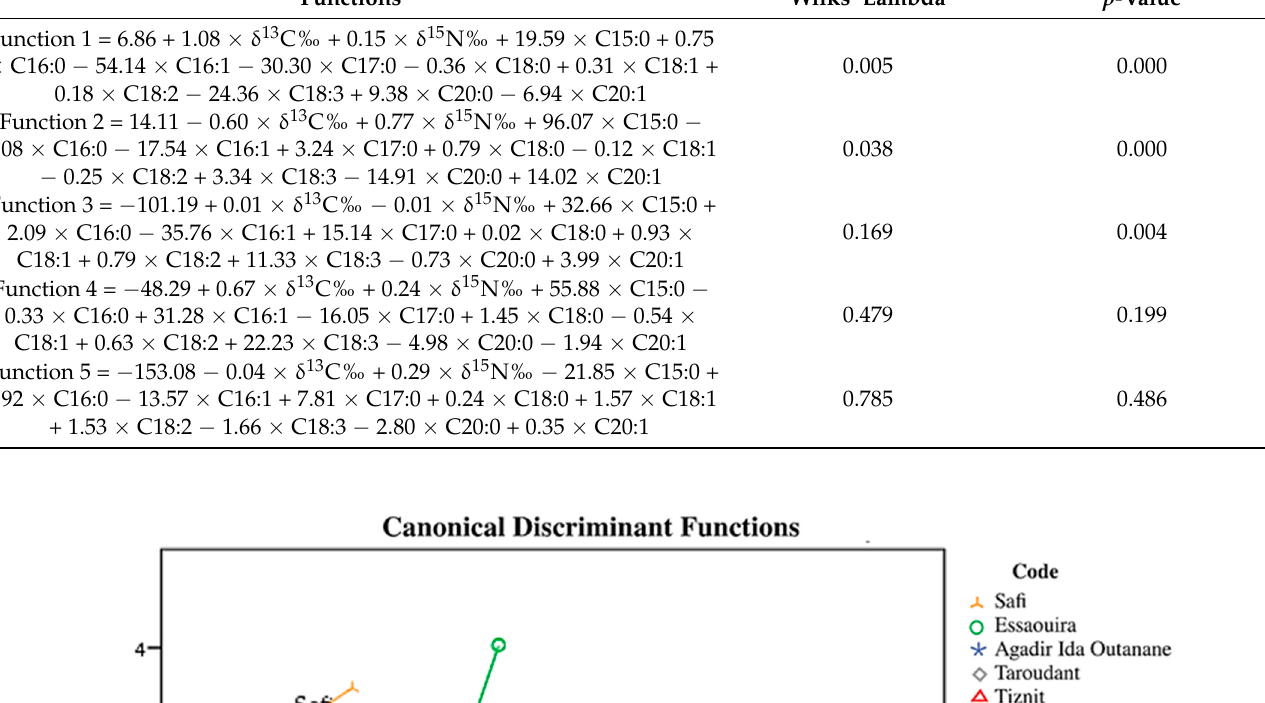
Table 3. Discriminant functions elaborated based on the combination of stable isotope ratios and fatty acid composition. Functions Wilks’ Lambda